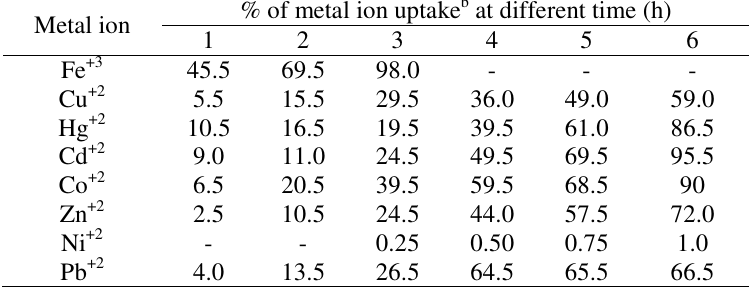
Table 6. Comparison of the rates of metal (M) ion uptake a by 2, 4-DHBOF-I terpolymers resins. Metal ion